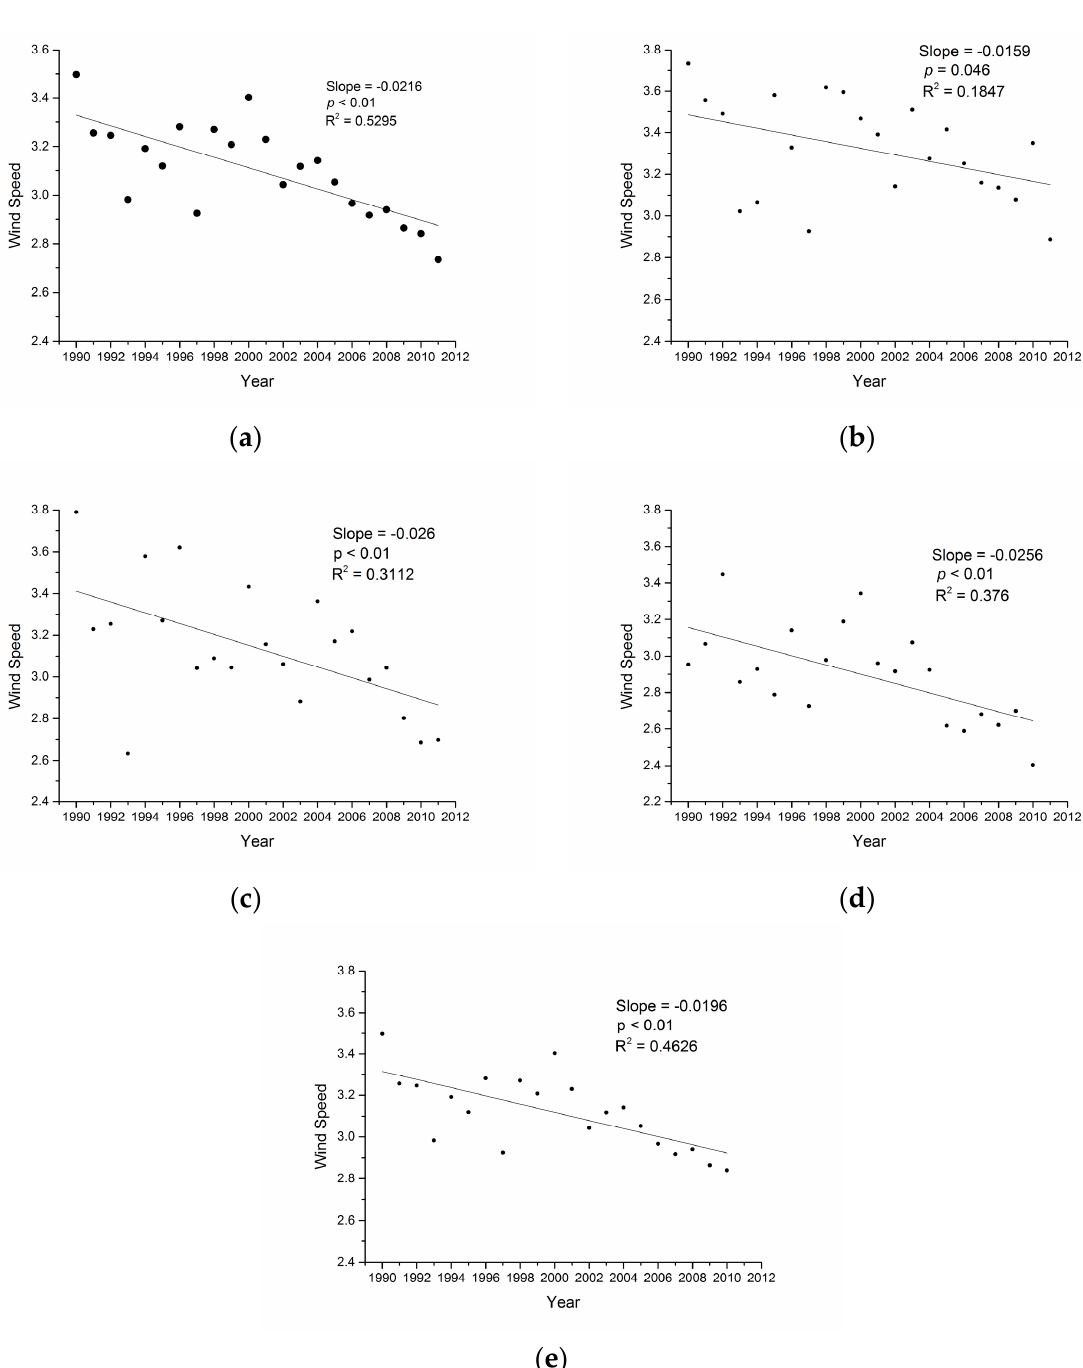
Figure 2. Plots showing the occurrence of wind direction during the study period (January 2005 to September 2011): ( a ) across the year; ( b ) in spring and summer; and ( c ) in fall and winter.